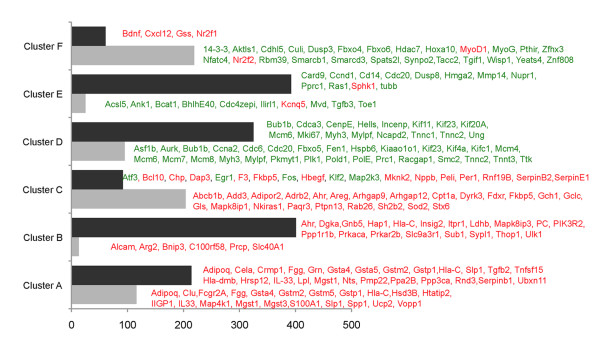
Major genes regulated by TSA or CBHA after 24 h. Incubation of H9c2 cells with either CBHA or TSA for 24 h led to enhanced (red) expression of most genes in clusters A, B and C while both HDACIs suppressed (green) a vast majority of the transcripts in clusters D, E and F.